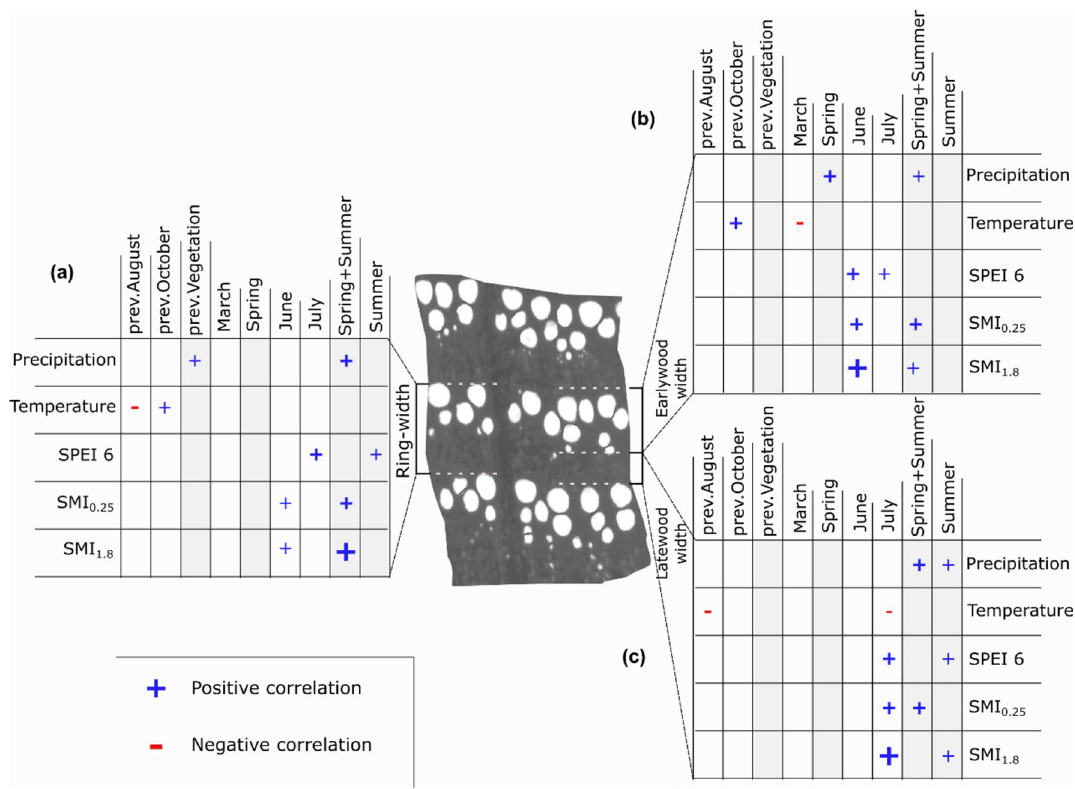
Figure 1. Strongest correlations between hydro-climatic variables (precipitation, temperature, standardized precipitation evapotranspiration index (SPEI 6), upper and total soil moisture index (SMI)) and ring-width chronologies (( a ): ring-; ( b ): earlywood; and ( c ); latewood-width). Columns highlighted in grey show seasonal averages. SMI: Soil moisture index. Symbol size indicates correlation strength for each ring-width variable. The strongest correlation in absolute terms was observed betwen earlywood and June SMI 1.8 ( r = 0.6), while the lowest correlation between latewood and July temperature ( r = −